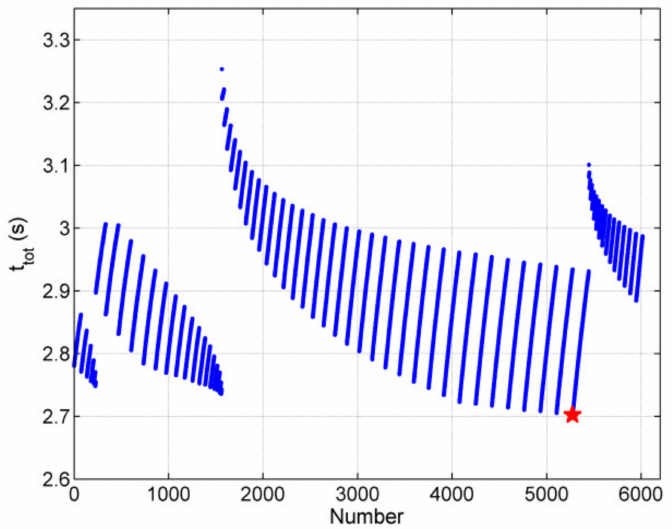
Figure 14. Calculation results of total charging time corresponding to all the variable vectors in X